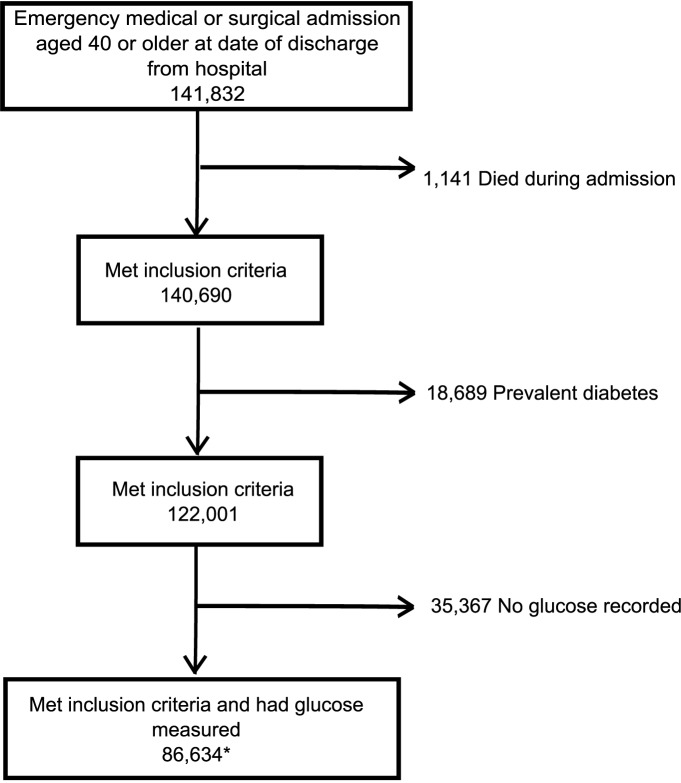
CONSORT style flowchart of patients included in analysis.* This group of 86,634 patients includes the n = 122 whose glucose was >20 mmol/l and so were assumed to have prevalent diabetes.